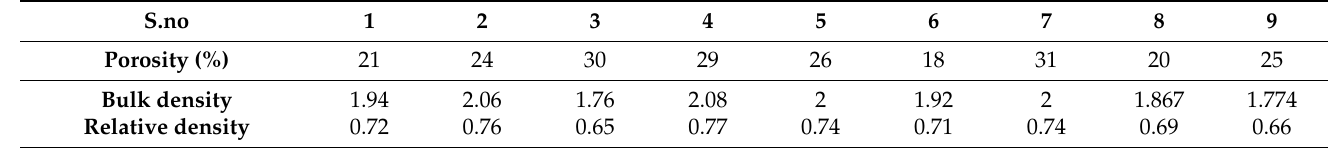
Table 4. Densities and porosities of porous Al composites for nine sets of